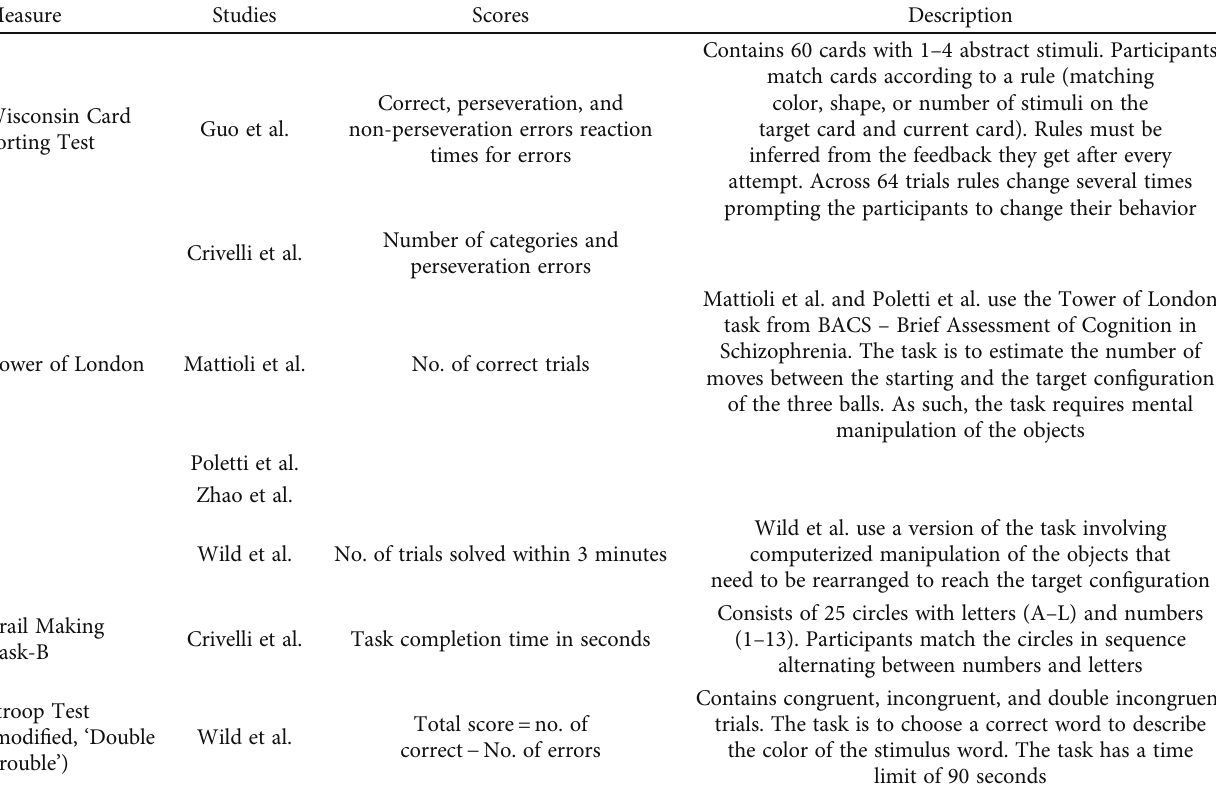
Table 2: Measures used in the selected studies.